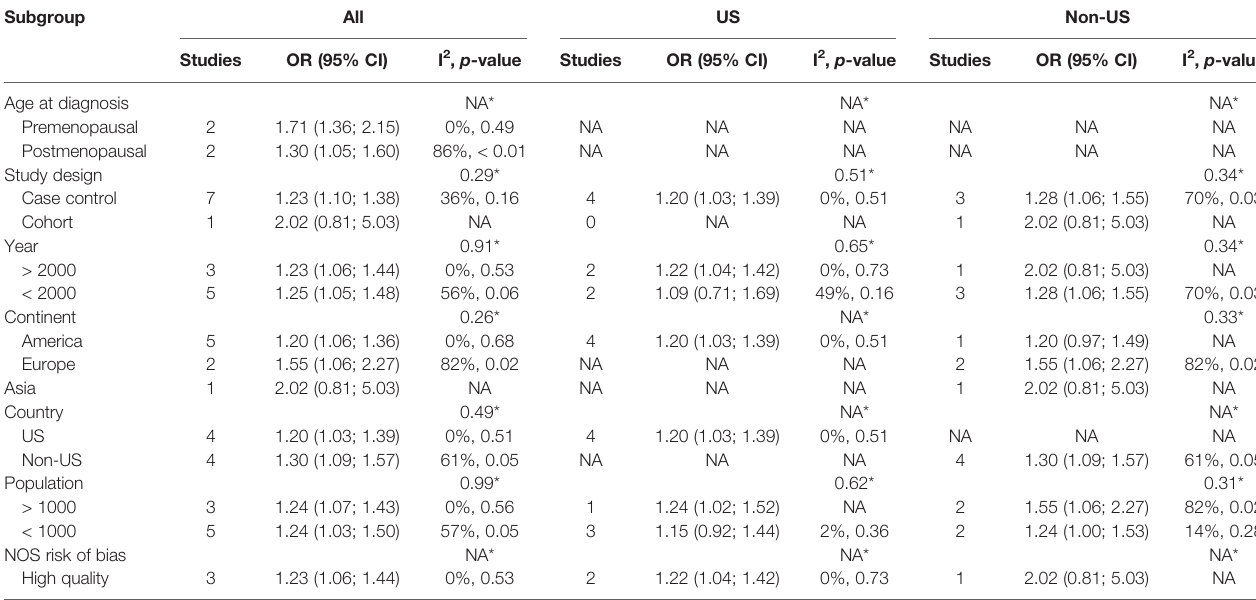
TABLE 2 | Results of the subgroup analysis. Subgroup All